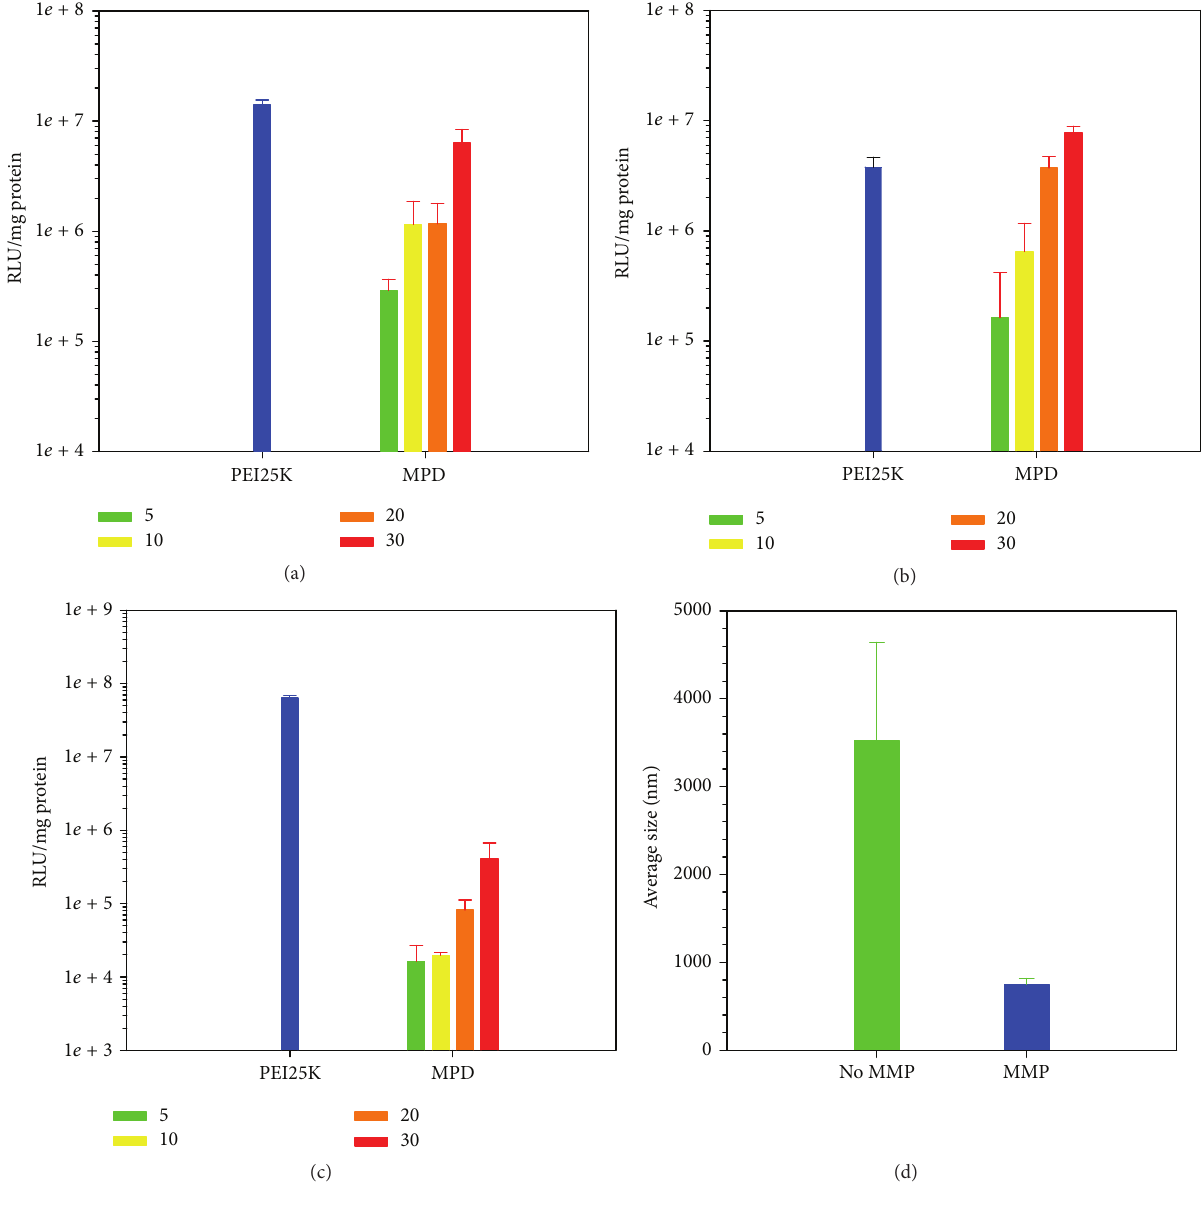
Figure 6: Transfection experiment results of MPD polyplexes in A549 (a), C2C12 (b), and HEK293 (c) cells. Numbers in boxes mean weight ratios of MPD polyplexes. PEI25k polyplexes were prepared at a weight ratio of 1. (d) Average sizes measurement result of MPD polyplexes (weight ratio: 20) in the absence or presence of